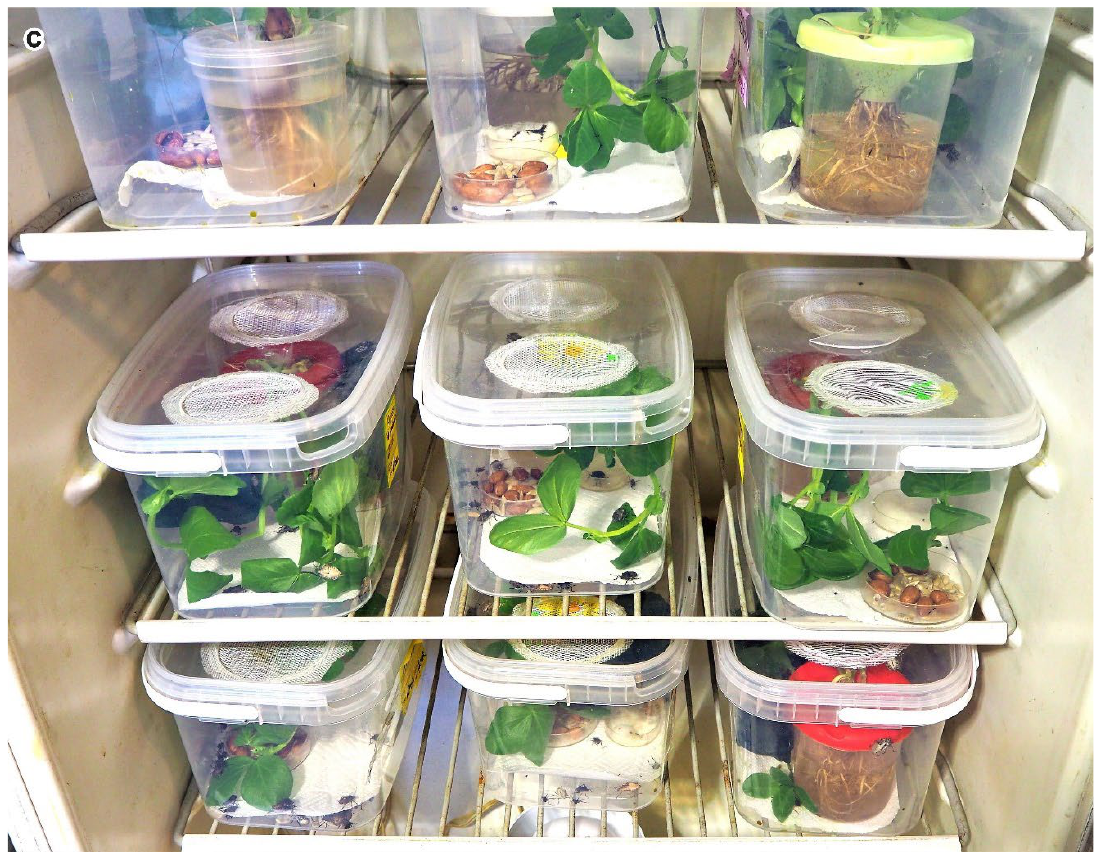
Figure 1. Experimental set-up: ( a ) ventilated transparent plastic containers for rearing Halyomorpha halys nymphs and adults during the experiment; ( b ) plastic containers used to support the labora- tory culture; ( c ) rearing incubator with pre-set temperature and photoperiod. Photos: K.